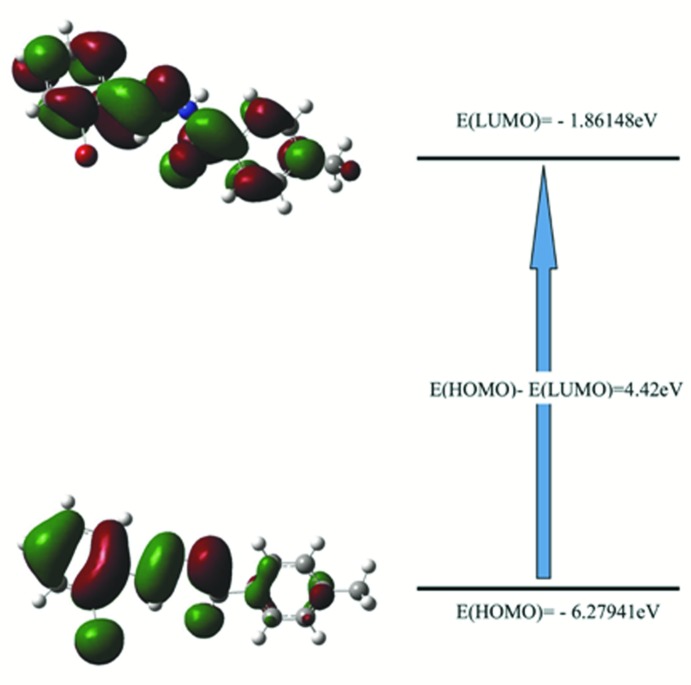
The energy band gap of the compound.